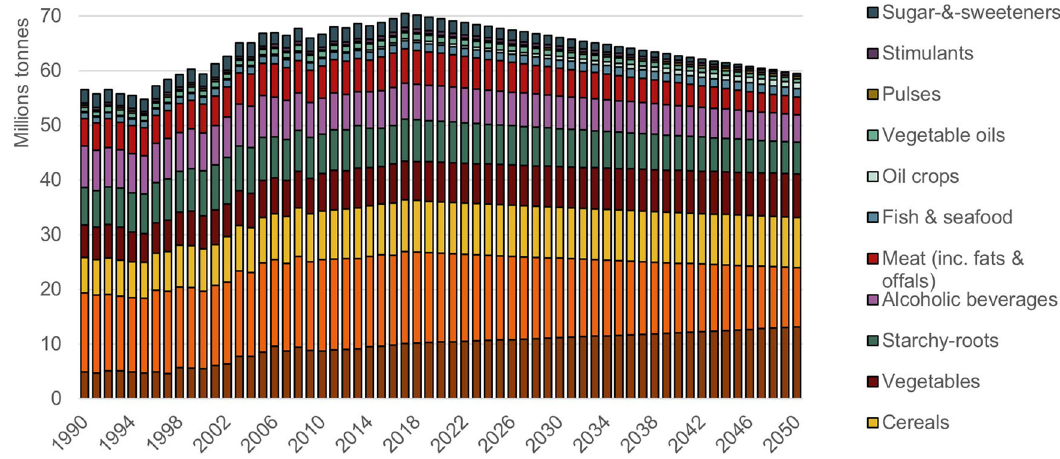
Fig. 1 Food Supply in the UK from 1990 to 2050 in the EEB pathway (tonnes) 1,37 – 40 . The 40 considered food groups have been aggregated for a better visibility. All fi gures and data can be found and can be explored through the pathway explorer provided as Supplementary Methods 2: ARISE